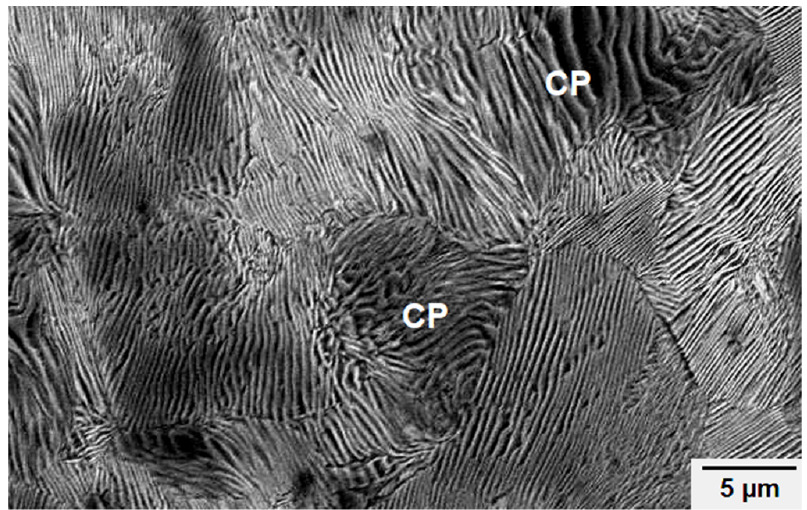
Figure 6. SEM micrograph of the initial microstructure for the high-carbon steel wire rod in as-rolled condition, showing a characteristic coarse pearlite (CP). Figure 7a–d indicates the microstructural evidences obtained by SEM of the center of the specimens, analyzed after the heat treatment, with the objective of indirectly vali- date the results of the simulation with the interlamellar spacing measurements for each cooling condition. The microstructure in the specimens reveals the presence of pearlite colonies of different size, as well as the complete transformation of pearlite under the analyzed conditions. Table 3 shows the results of the interlamellar spacing and average microhardness, HV 0.1/15 , and their relation with the calculated microstructural parameters from the proposed model. The difference between each specimen interlamellar spacing is determined by the cooling rate V a and the undercooling ∆ T ; both parameters are governed by the air velocity and the specimen diameter. An increasing air velocity leads to a higher cooling rate and undercooling, decreasing the pearlite interlamellar spacing [32], as can be seen in the specimens 1 and 2, both with a 0.010 m diameter and with the lowest values pearlite interlamellar spacing at the cooling conditions analyzed. Nevertheless, for the specimen 3 and 4, an increase in the diameter, increases the pearlite interlamellar spacing, even at the higher air velocity studied in this work, 14.7 m s − 1 . The average microhardness has a linear correlation with the undercooling degree; as the latter increases, higher values are obtained, which can be seen by comparing specimens 3 and 4. The specimen 3 showed the lowest value for average microhardness related to a decrease in the undercooling, an effect of the specimen